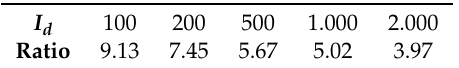
ratio to log I d F